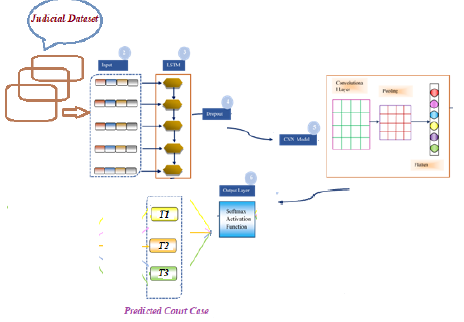
Figure 2. Overview of the hybrid CNN+BILSTM model for court judgment system.